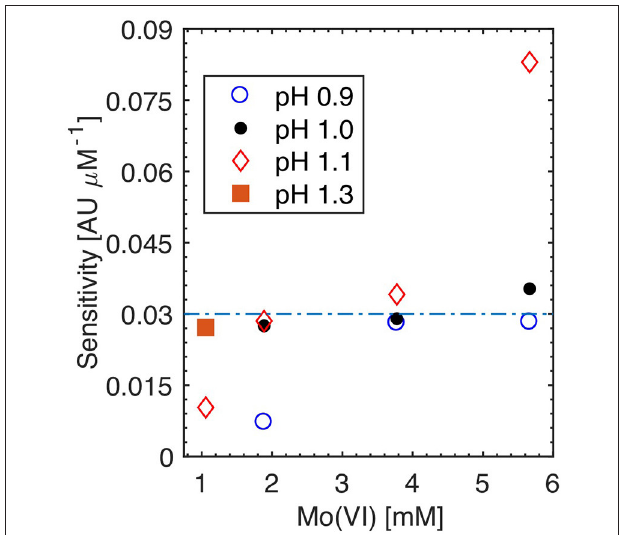
FIGURE 3 | Effect of Mo(VI) concentration and pH on analytical sensitivity. Symbols above the dashed line were characterized with a high reagent blank, highlighting inadequate Mo(VI) and pH reaction conditions (see text for details). The orange square represents the Mo(VI) and pH pair adopted in this study. Analytical sensitivity defined as the slope of a calibration curve (0, 1, 2 µ M PO 3 − 4 ) obtained using Sensor 1 (41 mm measurement cells) at each Mo(VI) and pH condition